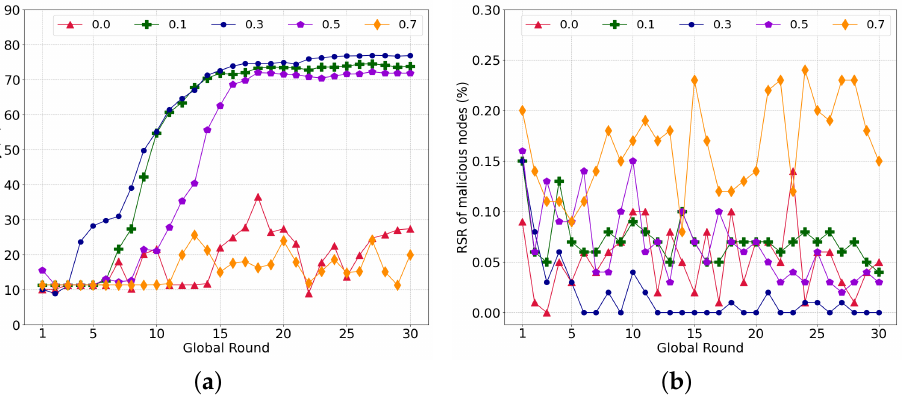
Figure 4. Performance subject to the various parameters α of similarity. ( a ) Global model accuracy; ( b ) Ratio of reference score of malicious nodes to total reference score per